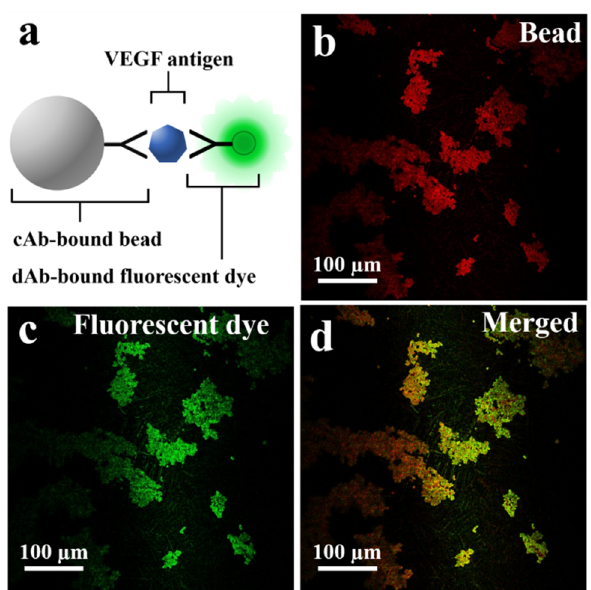
Figure 3. ( a ) Schematic of fluorescent dye-coupled VEGF on the microbeads. ( b ) The microbeads photographed with the longpass filter (>630 nm). ( c ) The dAb-bound fluorescent dye (green fluorescent protein) detected on the surface of the microbeads. ( d ) The merged image for the fluorescent dye and the microbeads.